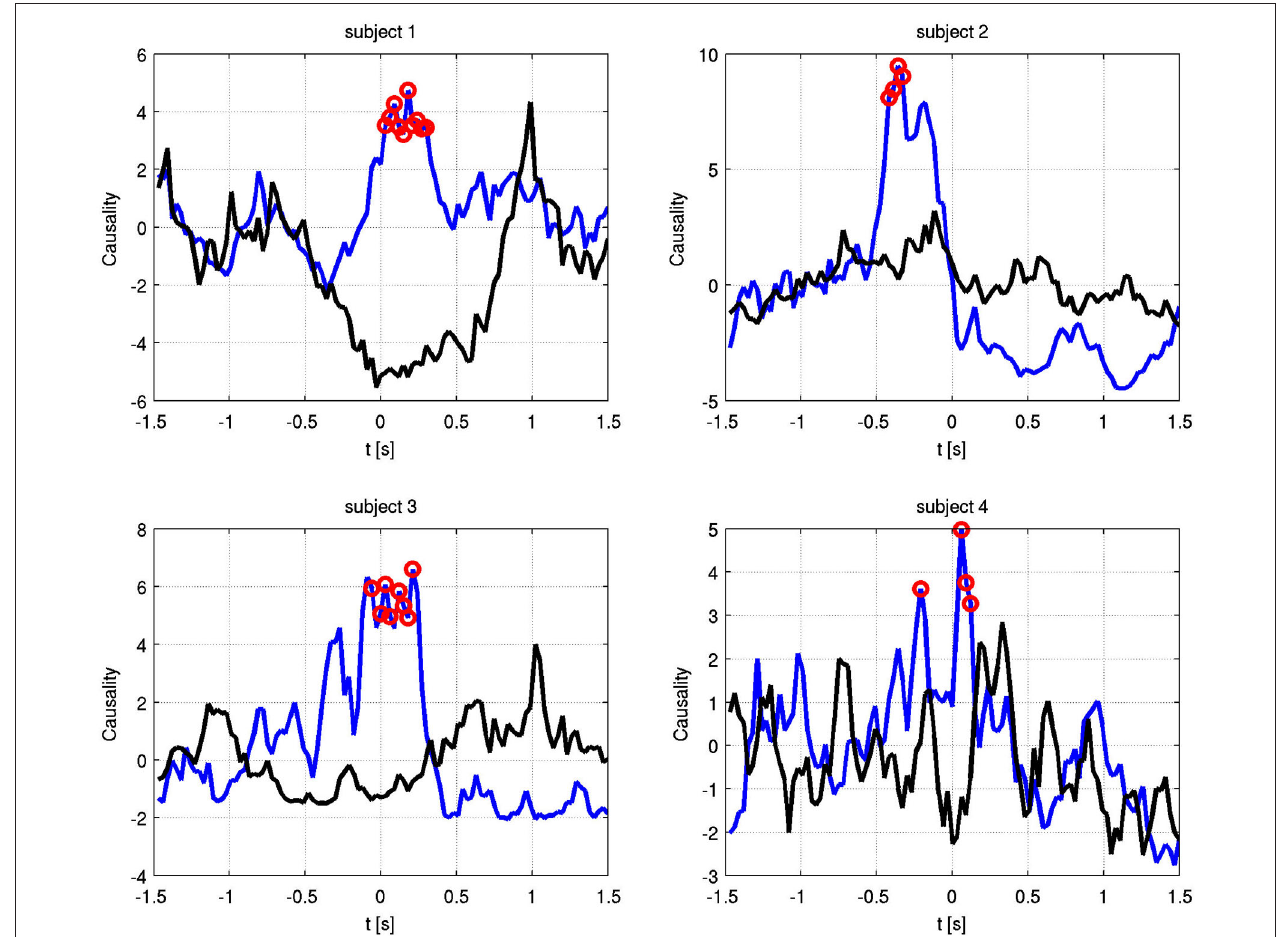
significant increase in causal flow. In all four subjects, there is unidirectional right to left flow, regardless of the finger that is